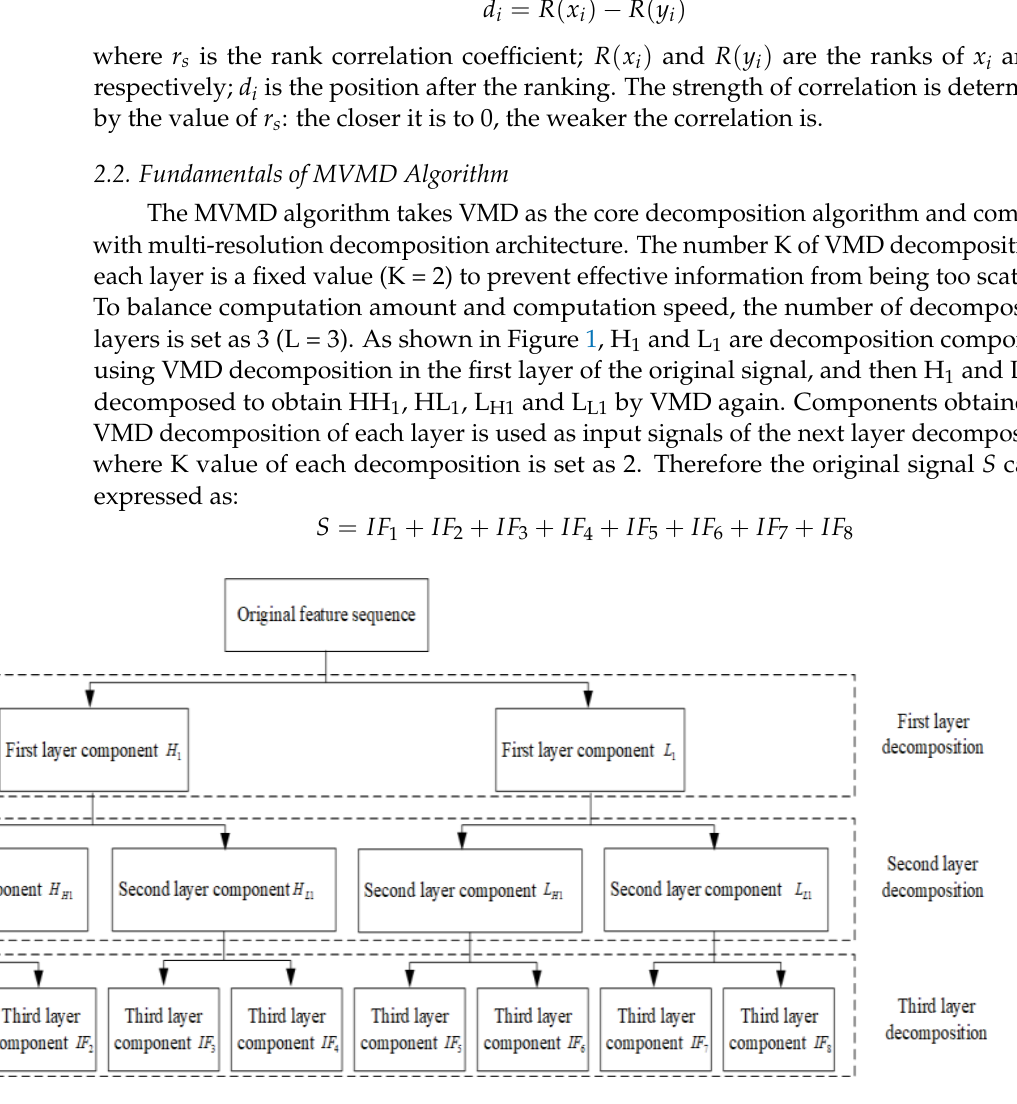
Figure 1. Architecture of MVMD decomposition.